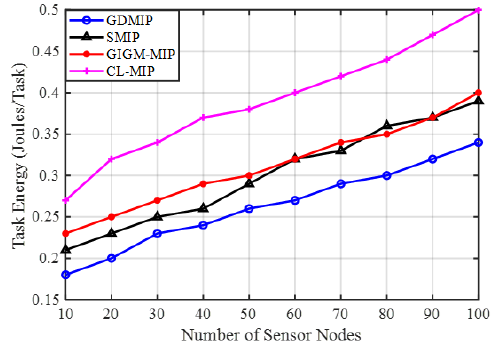
Figure 4. The Impact of Number of Sensor Nodes on Energy Consumption.